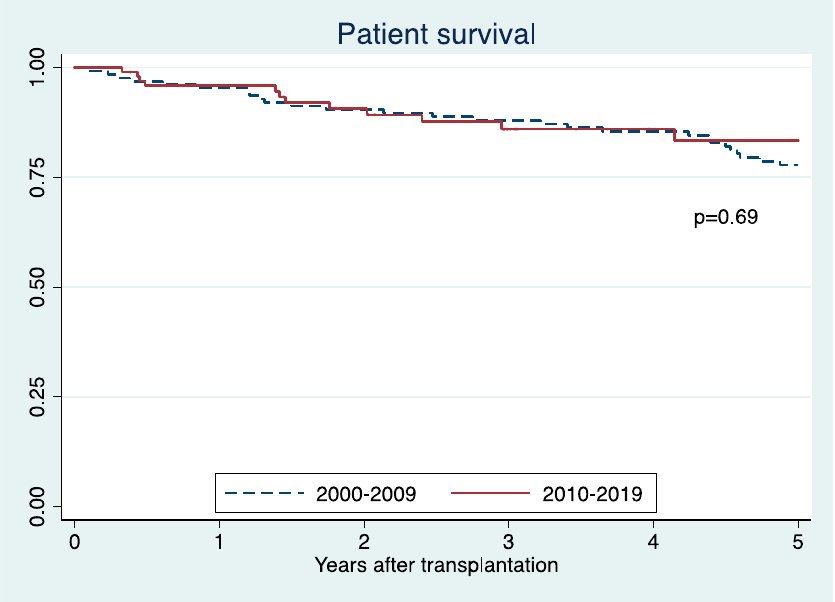
Figure 6. Patient survival of sickle cell disease recipients in 2010–2019 and 2000–2009.